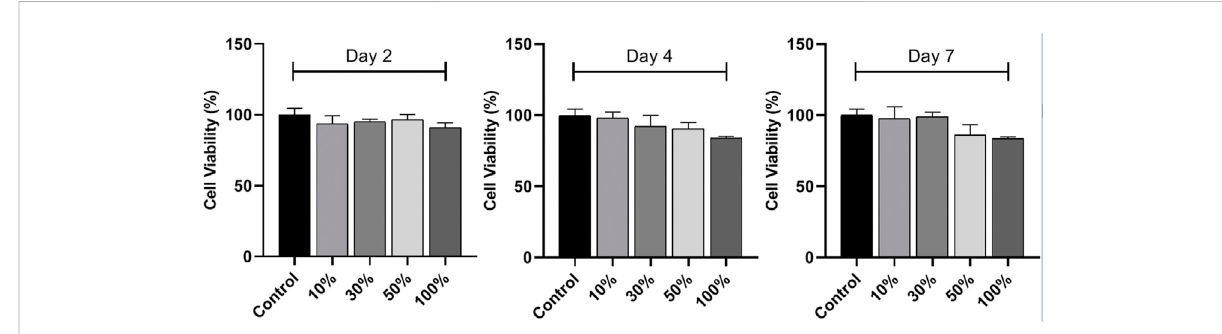
FIGURE 4 In vitro cytocompatibility of the HA/CS/PCL scaffold. CCK-8 assay of L929 cell proliferation on the HA/CS/PCL scaffold after 2, 4, and 7 days incubation. The data represent the mean ±